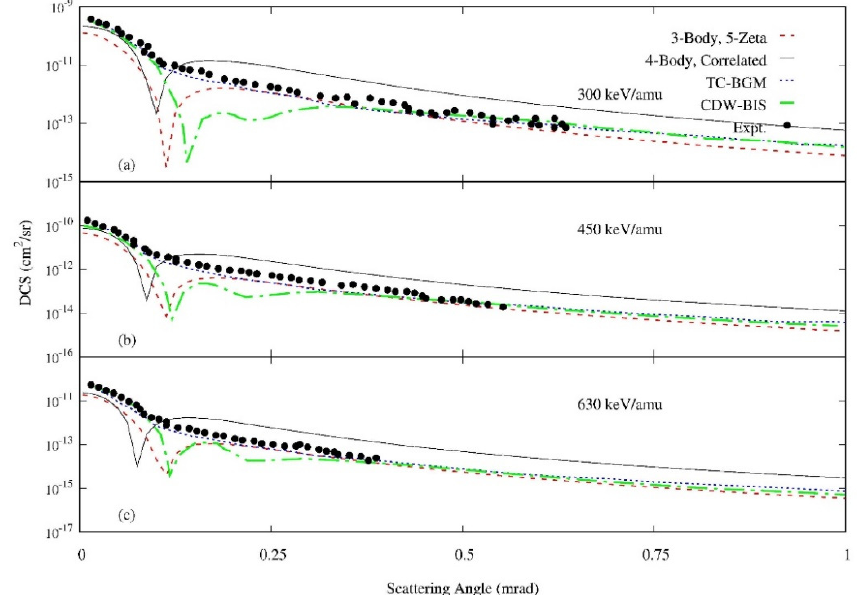
Figure 5. Di ff erential cross sections for 3 He 2 + + He single electron capture to the ground state with the residual He + ion also in the ground state. Results from the three-body and four-body models are compared to experiment [7] and other theoretical models [7,8] Incident projectile energies are ( a ) 300 keV / amu, ( b ) 450 keV / amu, and ( c ) 630 keV / amu. In all cases, the captured electron is known to be in the ground